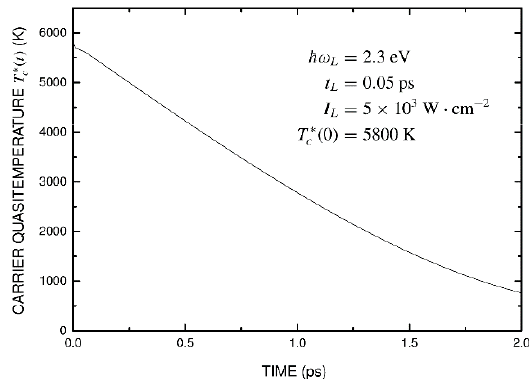
Figure 15. Evolution of the carrier’s quasitemperature, calculated in the conditions of the experiment in the caption to Figure 14 (Vasconcellos 91 ).